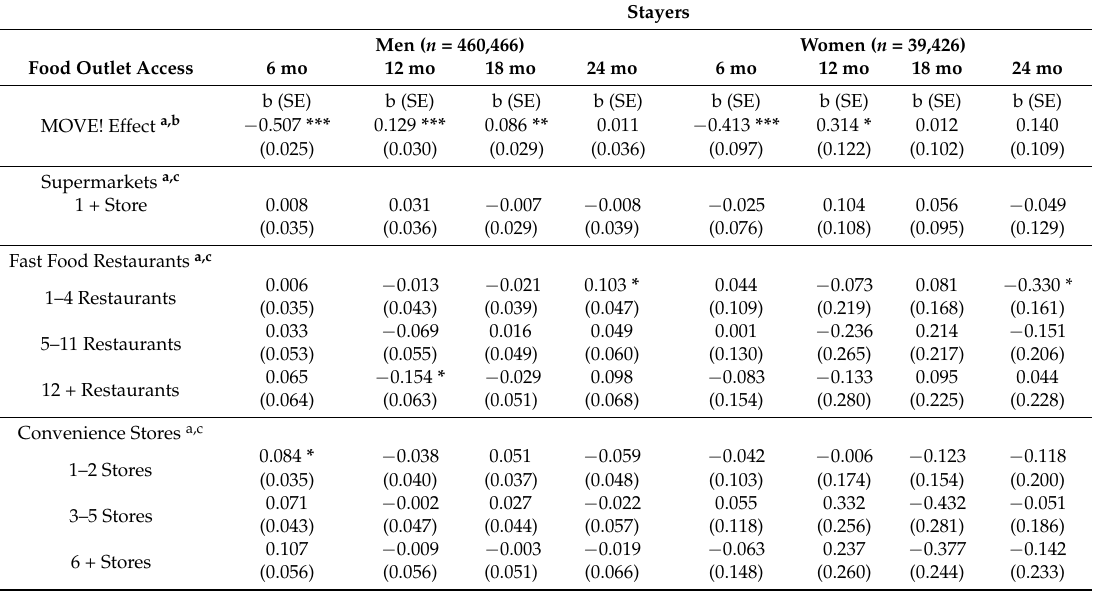
Table 3. MOVE! effect on longer-term incremental BMI change at 12, 18, and 24 months (mo) by food outlet access, “stayers”